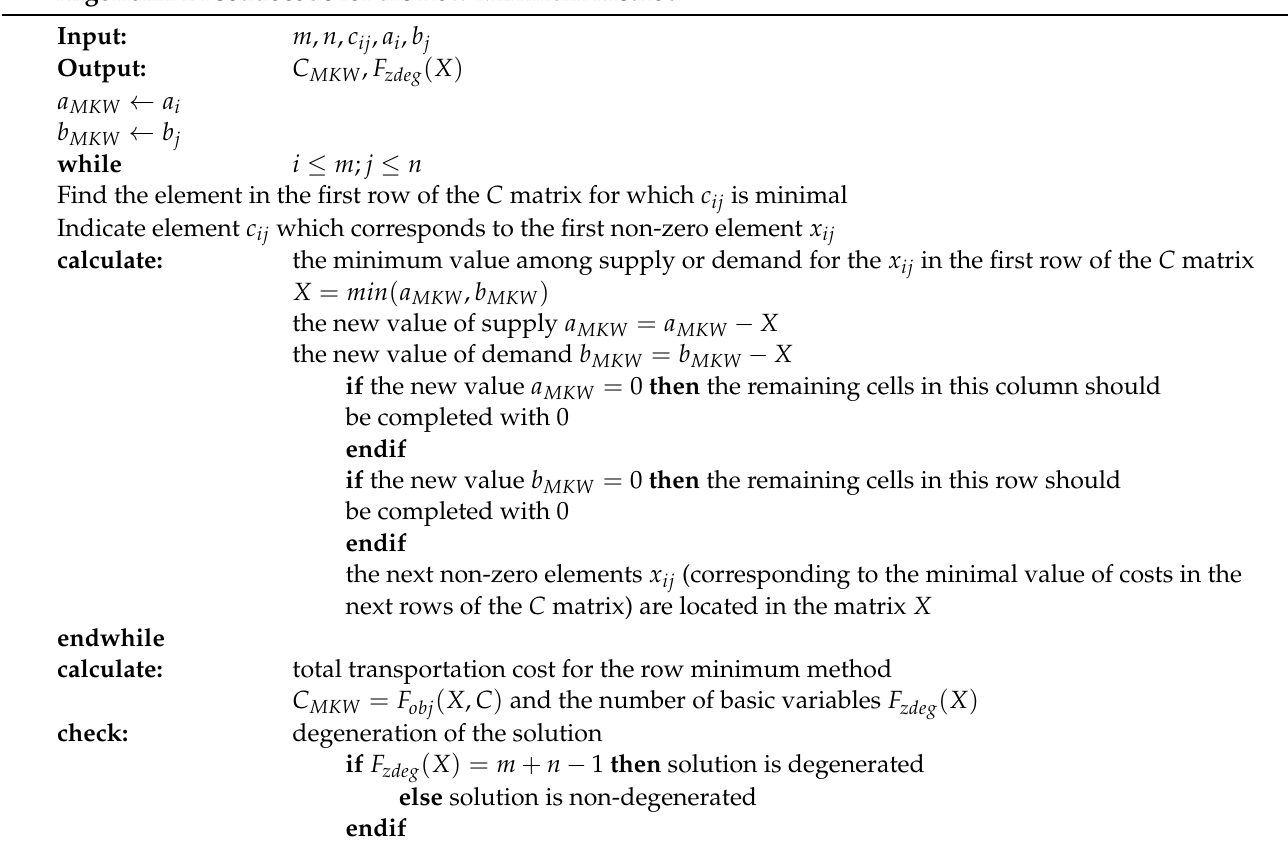
Algorithm 2 Pseudocode for the Row Minimum